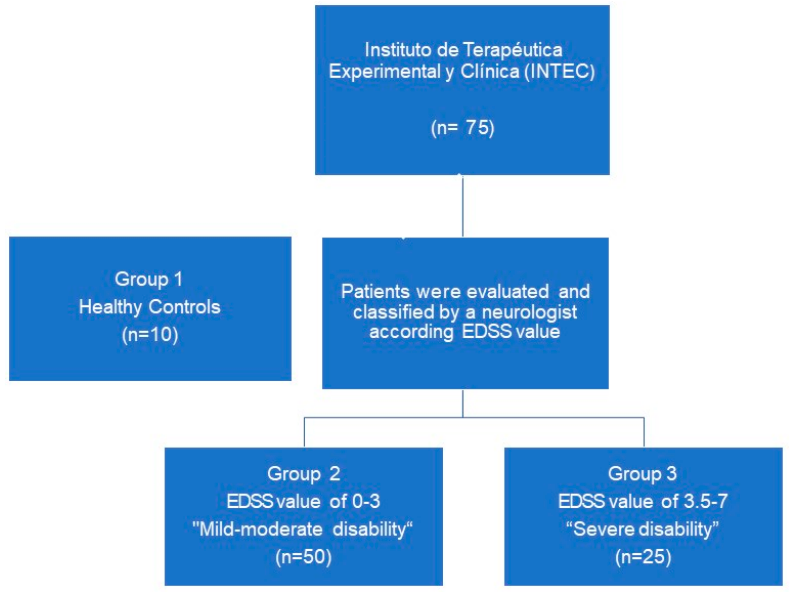
Figure 6. Patient selection